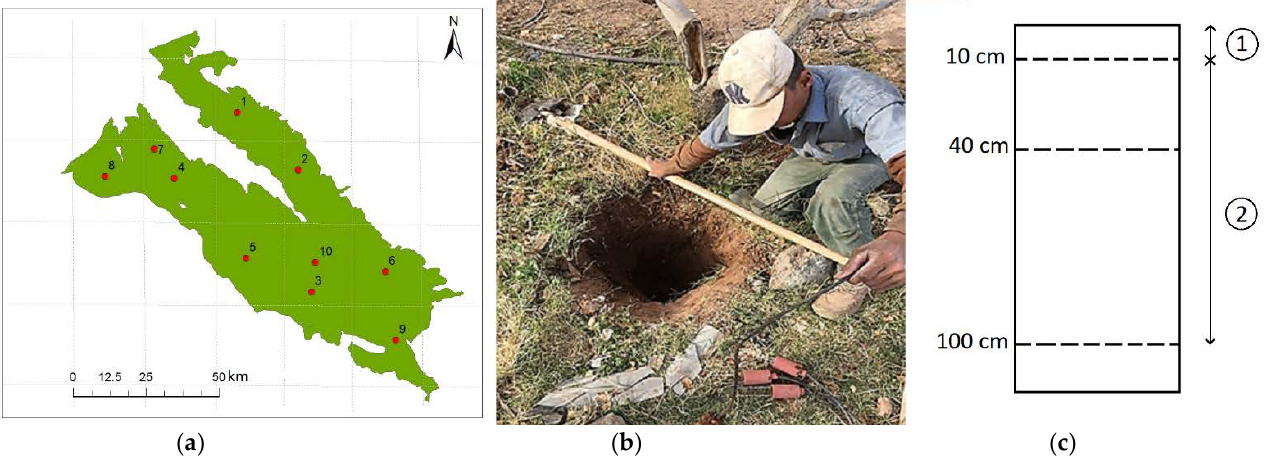
Figure 2. ( a ) Location of stations in Rafsanjan plain, ( b ) REC-P55 SM sensors manufactured by Ansari and Hassanpour [40] installed in study wells at three different depths of 10, 40, and 100 cm, and ( c ) two layers of surface and deep (root zone) soil considered in the SMAR